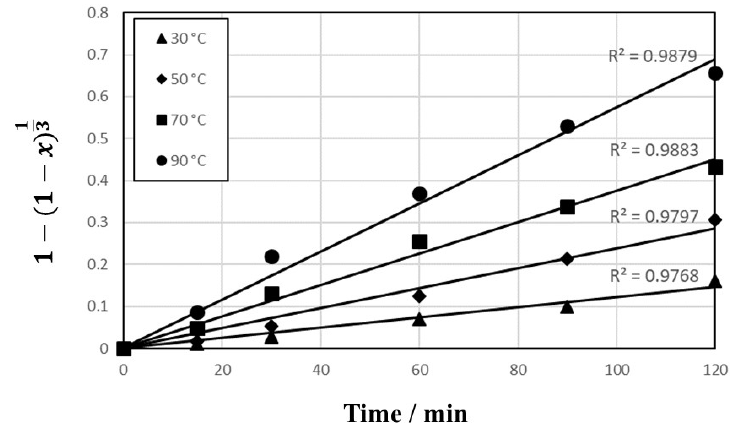
Figure 8. Plot of 1 − (1 − x ) 1/3 vs. T as a function of time for Cu leaching at temperature 30–90 °C in 1 mol/L sulfuric acid solution.